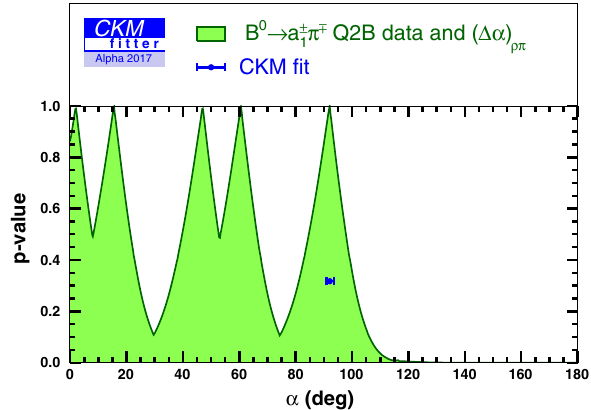
Fig. 52 One-dimensionalconstrainton α derivedfromtheQ2B B 0 → π ∓ analysis, assuming that Δα = (α − α a ± 1 in the case of the B 0 → (ρπ) 0 Dalitz analysis. The interval with a dot indicates the indirect determination introduced in Eq. (2)